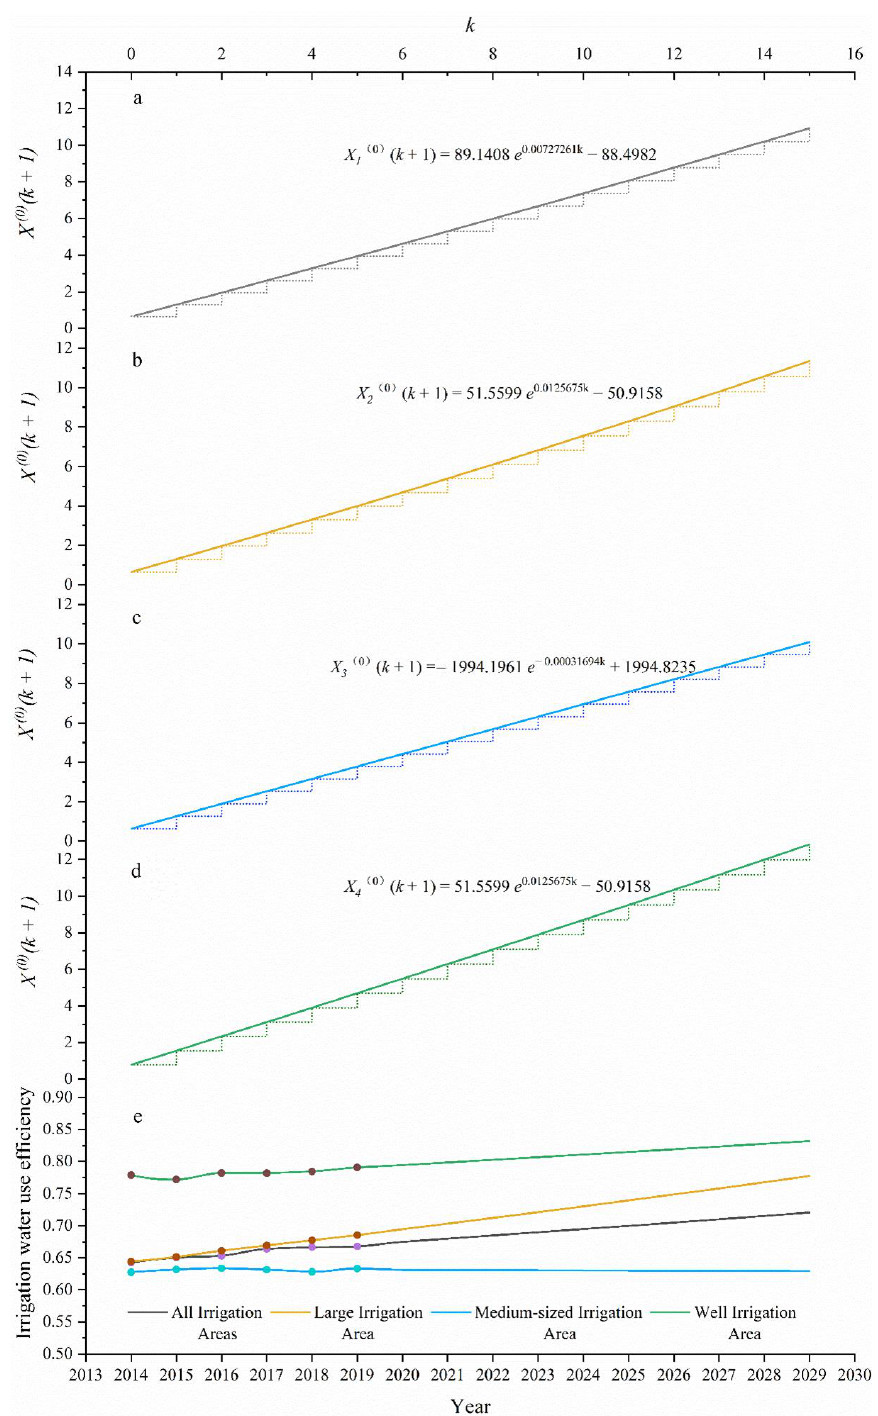
Figure 12. Changes in the effective utilization coefficient of irrigation water in different types of irrigation areas (grey model curves for ( a ) all irrigation areas, ( b ) large irrigation areas, ( c ) medium-sized irrigation areas, and ( d ) well irrigation areas in the next 10 years; ( e ). variations in various types of irrigation areas from 2014 to 2029.